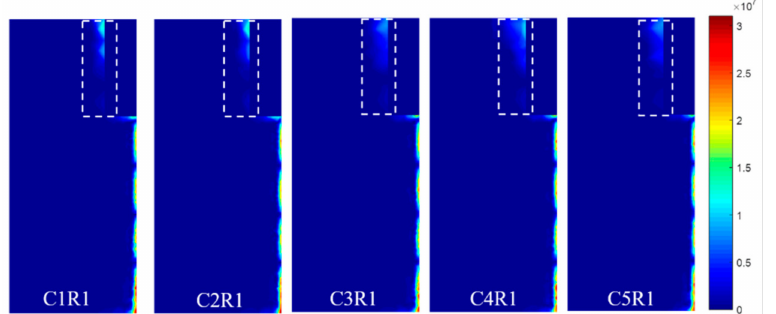
Figure 10. The side view of EC in Model